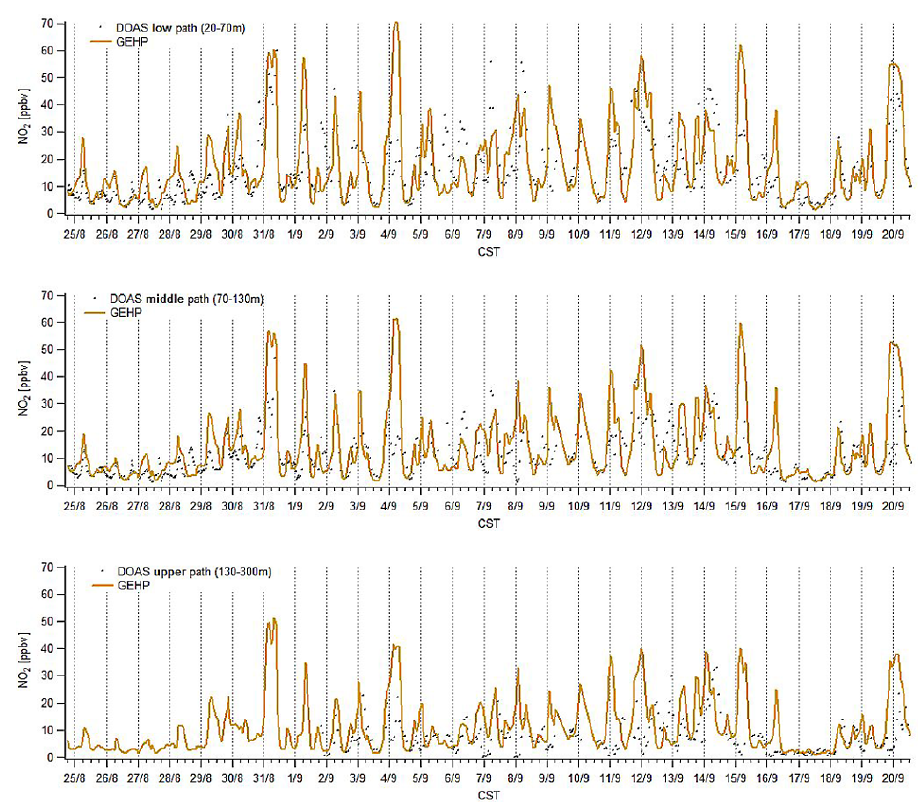
Fig. 3. Time series comparison of NO 2 measured from the Moody Tower by DOAS low light-path (top graph), middle light path (middle graph), and upper path (bottom graph) with simulated mixing ratios for 25 August–20 September 2006.